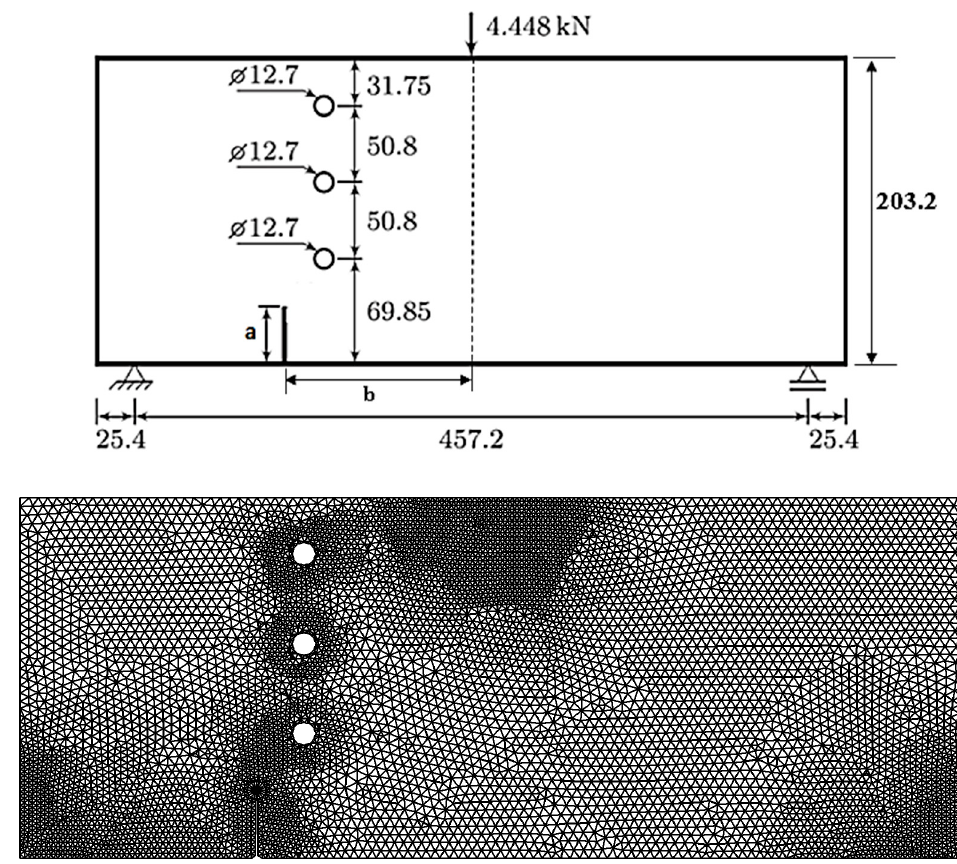
Figure 8. Problem statement for the PMMA specimen (dimensions in mm) and initial adaptive dens mesh. dens